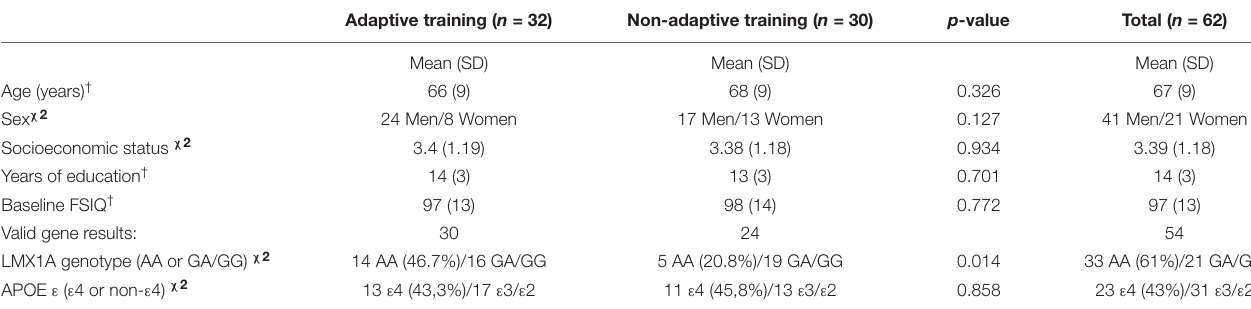
TABLE 1 | Clinical characteristics for the adaptive and non-adaptive training groups including